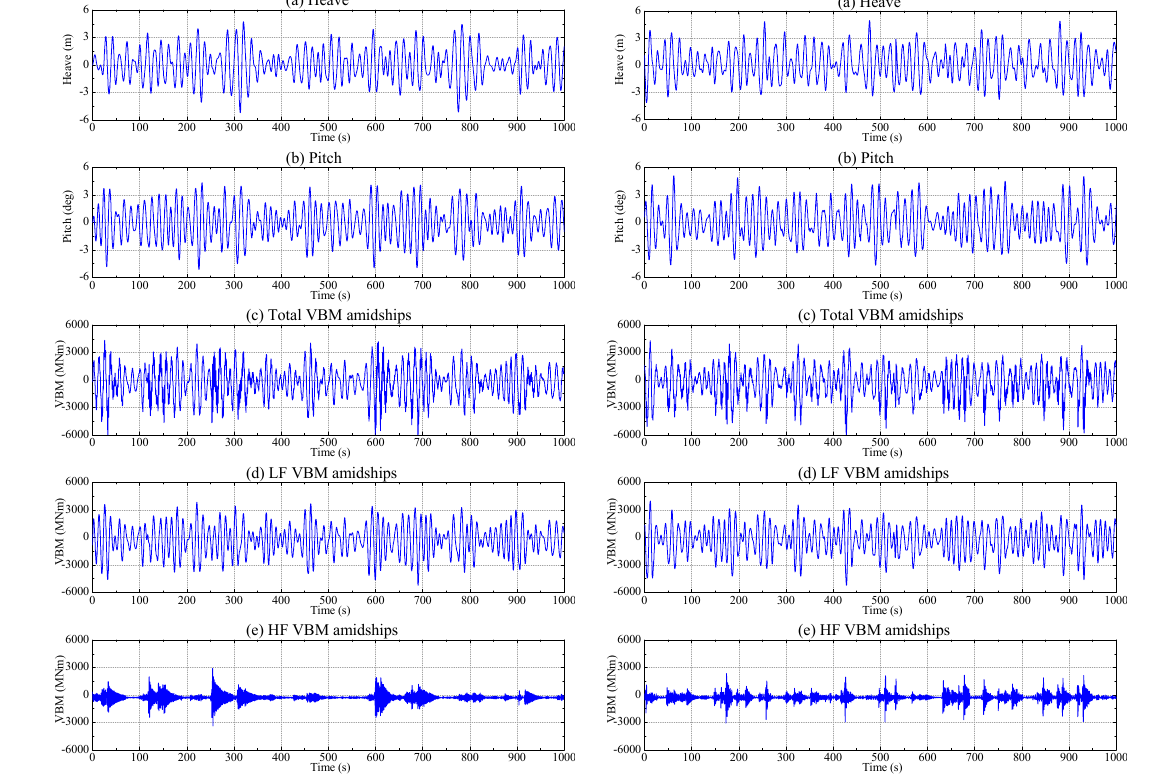
Figure 5. Time series of motion and loads in Condition 1. ( left ) Numerical results; ( right ) experimental Figure 5. TimeseriesofmotionandloadsinCondition1. ( left )Numericalresults; ( right results.